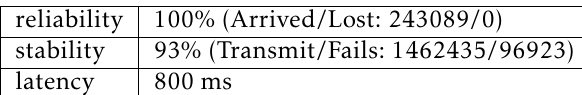
Table 1. Key network performance